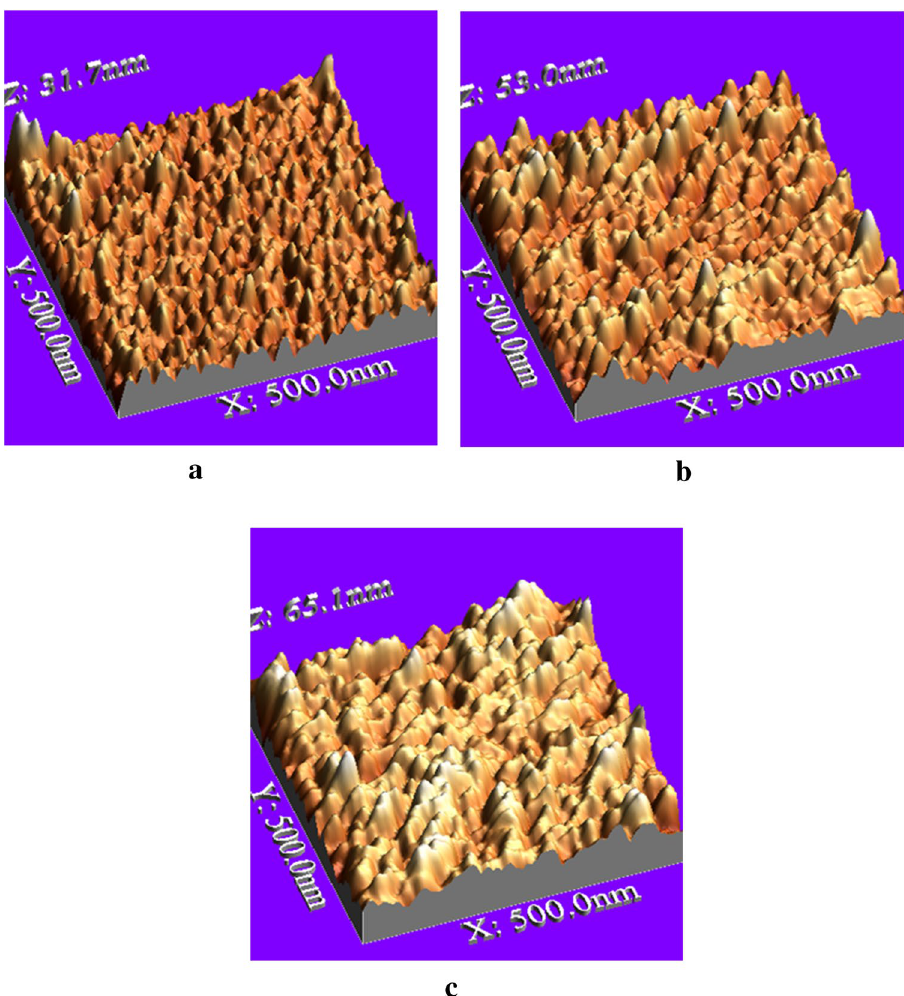
Figure 4. Representative AFM images of samples: ( a ) #1, ( b ) #2 and ( c ) #3 (WSxM ver 5.0 software, http:// www.wsxm.es/).